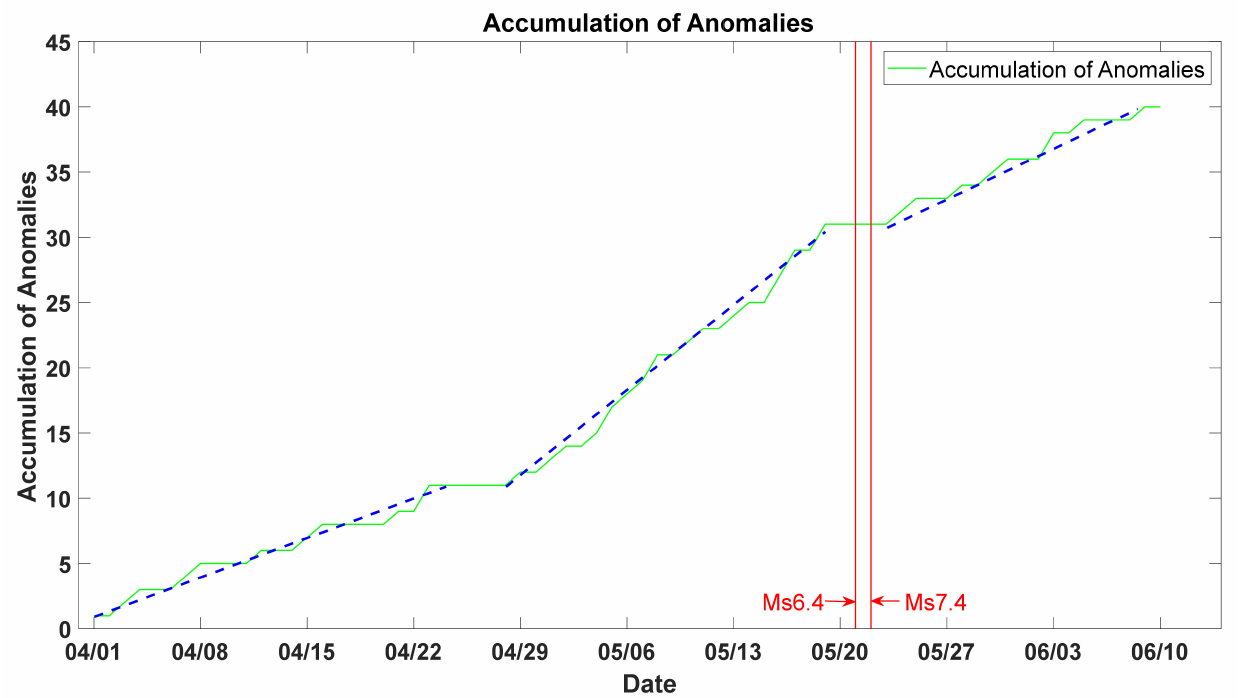
Figure 7. Accumulation of anomalies. Red line indicates the date of the earthquake, green line is the accumulation of anomalies, and blue lines are the trend of the accumulation of anomalies. Obviously, the trend from 1 April to 23 April is consistent with the trend from 23 May to 10 June, and the trend from 28 April to 20 May has a relatively large slope. Dates with poor space environment are not